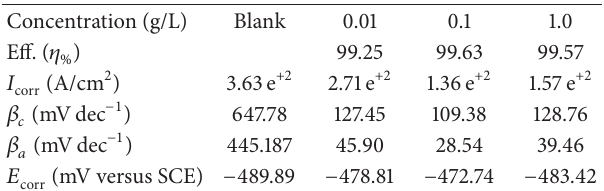
Table 2: Potentiodynamic polarization parameters for pipeline SO with and without different concentrations of steel in 0.5 M H 2 4 Brassica oleracea extract at 303 K.